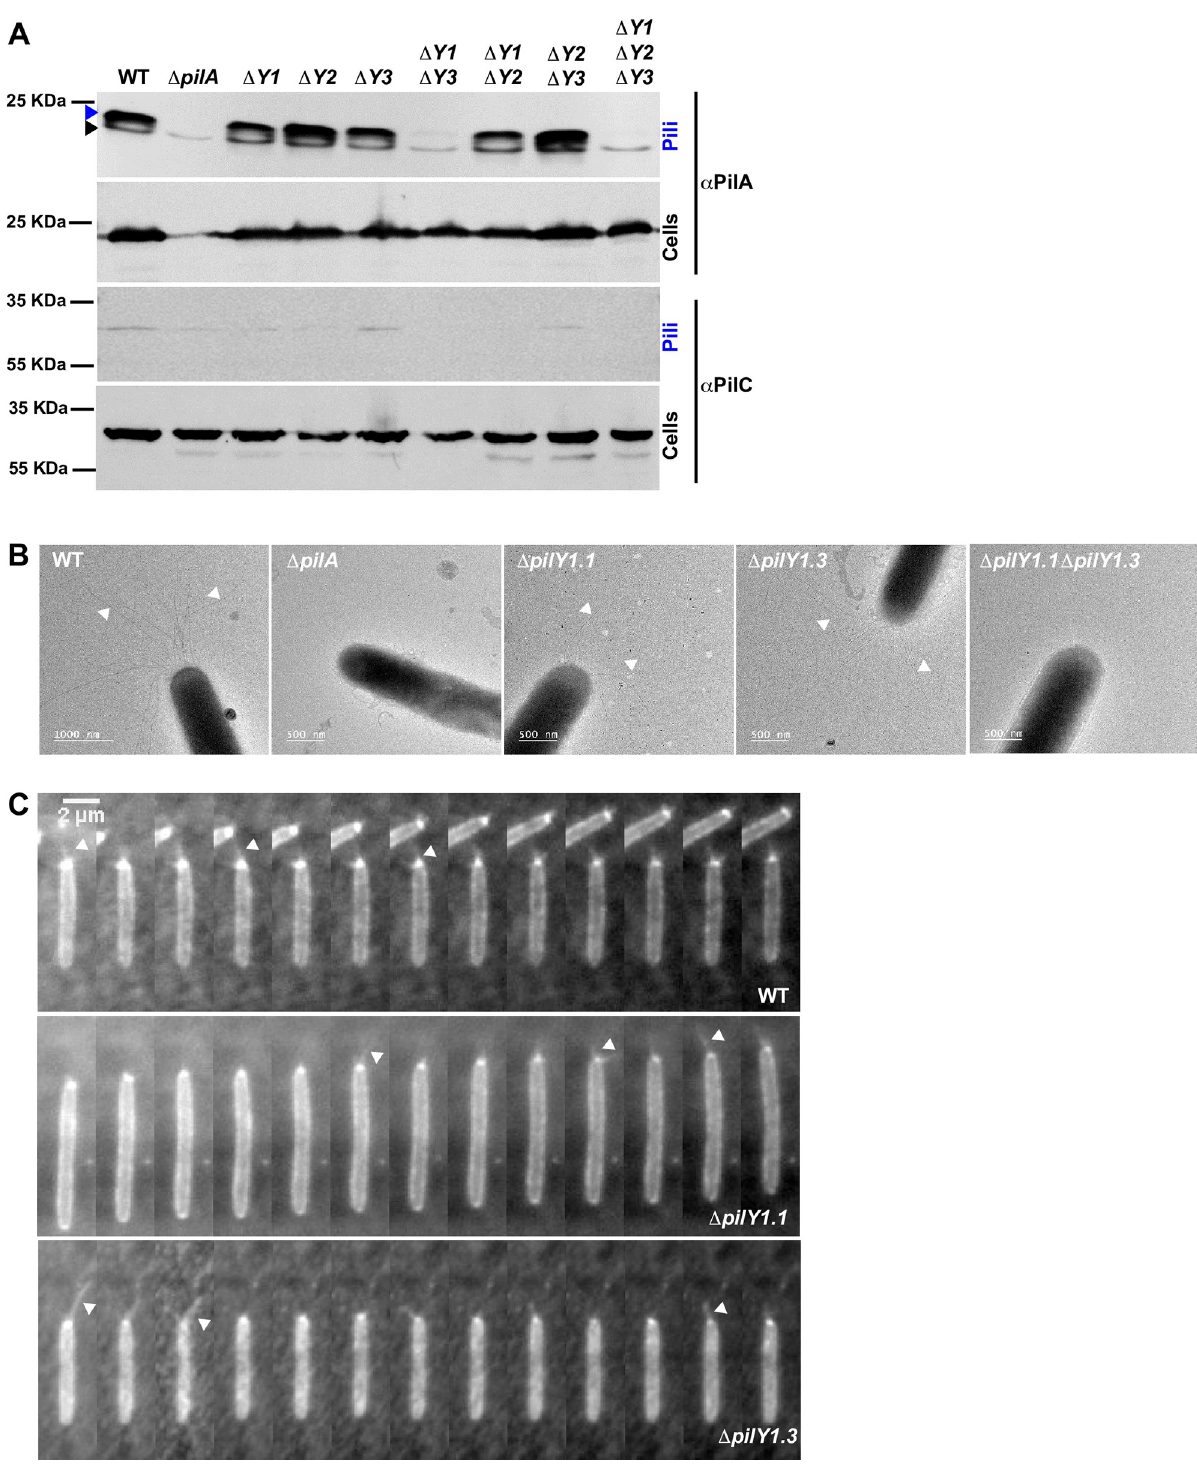
Fig 6. PilY1.1 and PilY1.3 are essential for T4P formation. (A) Western blot detection of PilA and PilC in sheared-off T4P and total cell lysates of DZ2 (wild type), TM389 ( Δ pilA ), EM808 ( Δ pilY1 . 1 ),EM882 ( Δ pilY1 . 2 ),EM856 ( Δ pilY1 . 3 ),EM857 ( Δ pilY1 . 1 Δ pilY1 . 3 ), EM879 ( Δ pilY1 . 1 Δ pilY1 . 2 ), EM880 ( Δ pilY1 . 2 Δ pilY1 . 3 ), and EM881 ( Δ pilY1 . 1 Δ pilY1 . 2 Δ pilY1 . 3 ). Membranes were probed with α PilA antibodies (top rows) and α PilC antibodies (bottom rows). The blue arrowhead indicates the band corresponding to the PilA protein and the black arrowhead indicates a cross-reacting band. (B) TEM micrographs of cells from the indicated strains. Arrowheads indicate T4P on the cell surface. (C) 5s time-lapse series, obtained by TIRF microscopy, of labeled T4P pilin filaments and polar cluster enrichment of the indicated strains bearing att mx8 ::P pilA -pilA D71C .